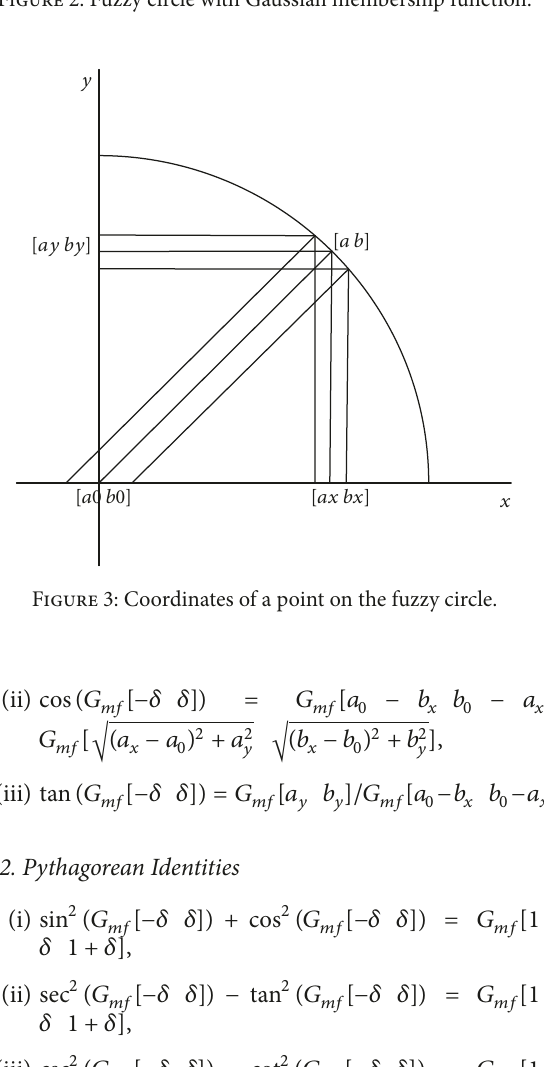
Figure 2: Fuzzy circle with Gaussian membership function.